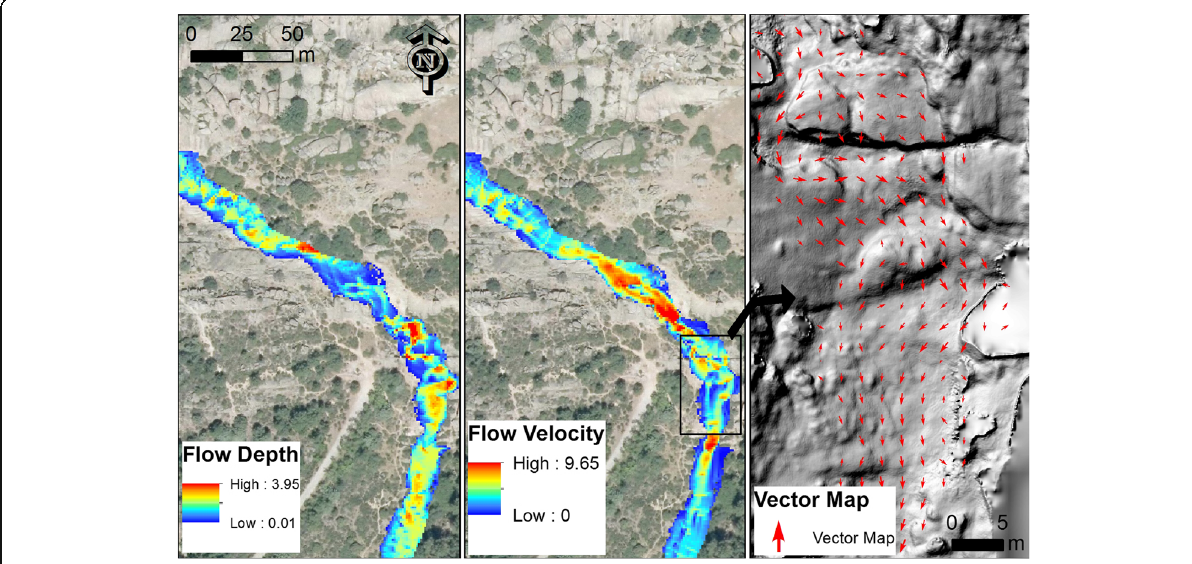
Fig. 8 Results of the 2D hydraulic model developed in the area of La Pedriza. This model refers to the variables flow depth (left) and velocity (centre). Noticeable variations observed in both variables are the result of large-scale roughness of bedrock and may be responsible for the development of large-scale bedrock forms, such as pools, potholes and grooves. The image on the right represents flow directions vectors, which could be correlated to occurrence of the abovementioned